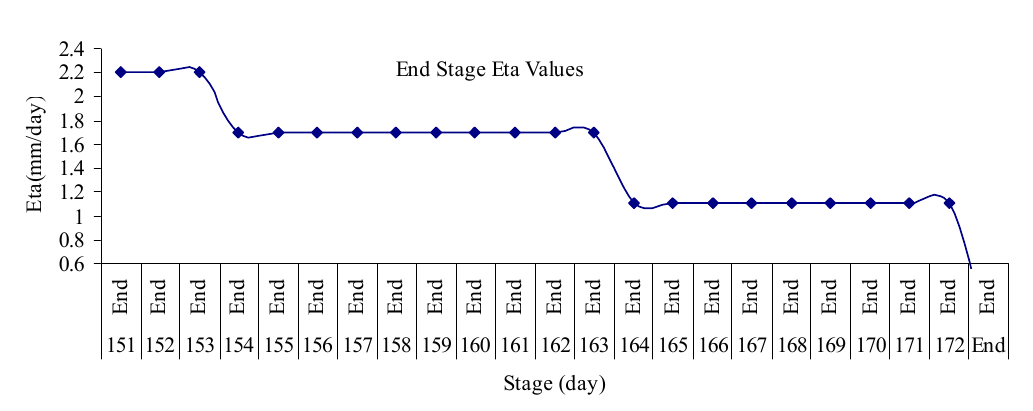
Figure 14. Mid. Stage water requirement.